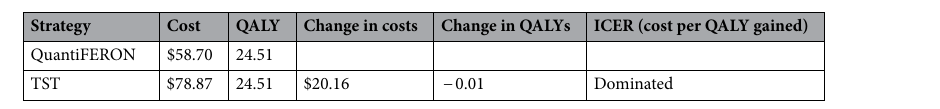
Table 5. Base case results per